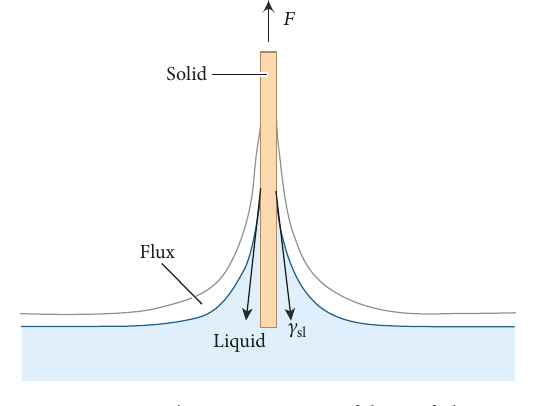
Figure 1: The stress situation of the Cu foil.